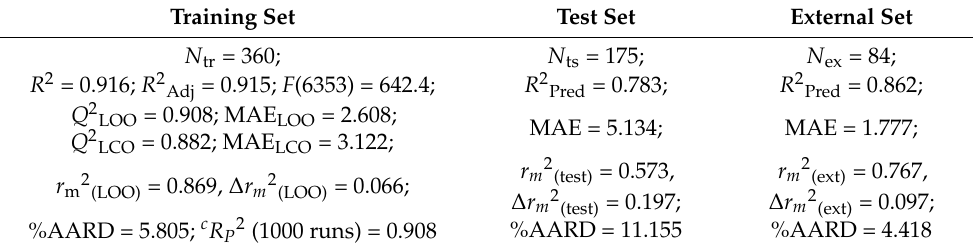
Table 4. MLR statistical results for model M12—Equation (3) a .